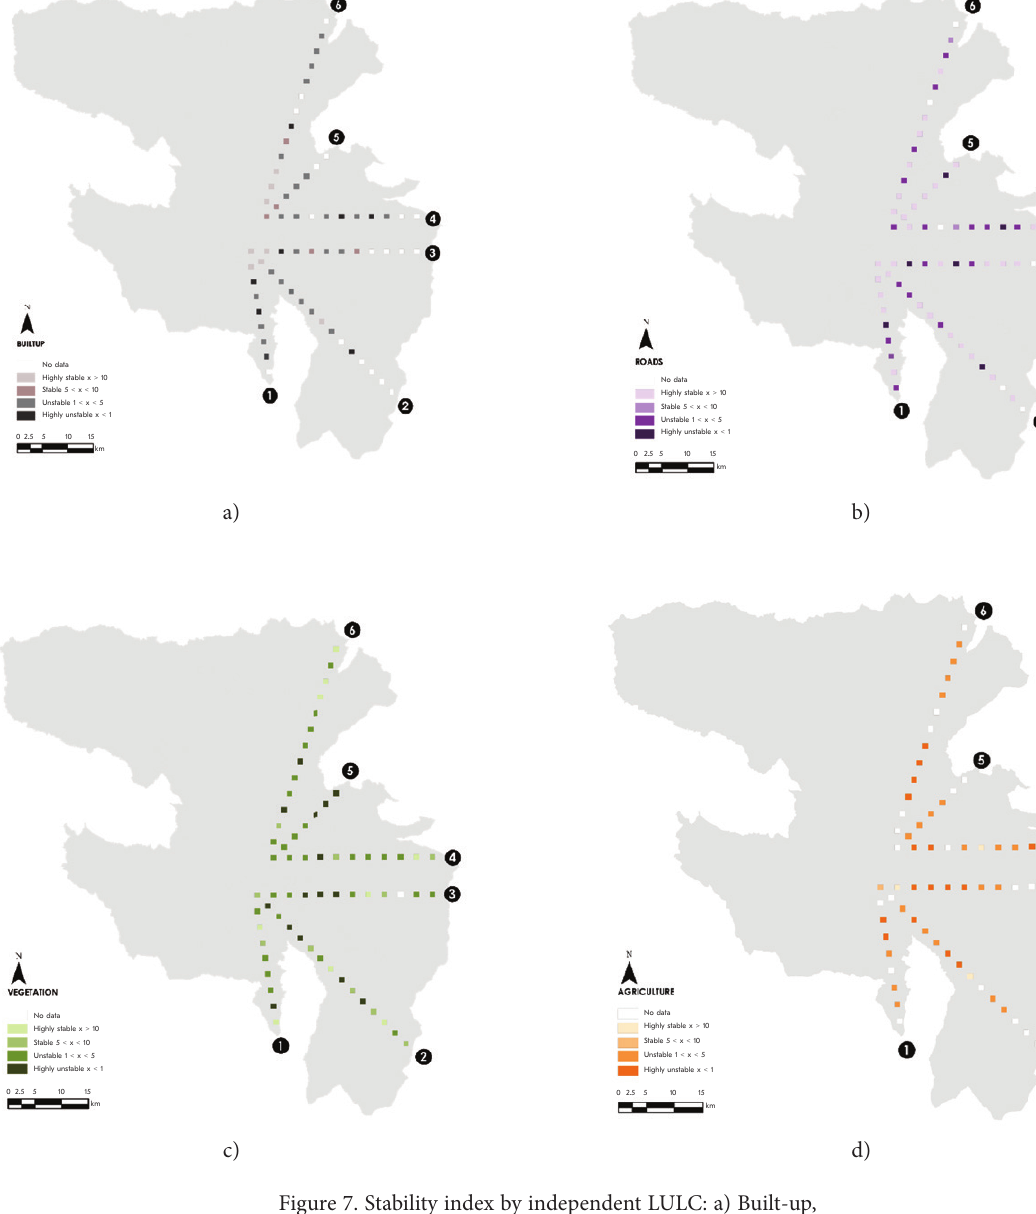
Figure 7. Stability index by independent LULC: a) Built-up,